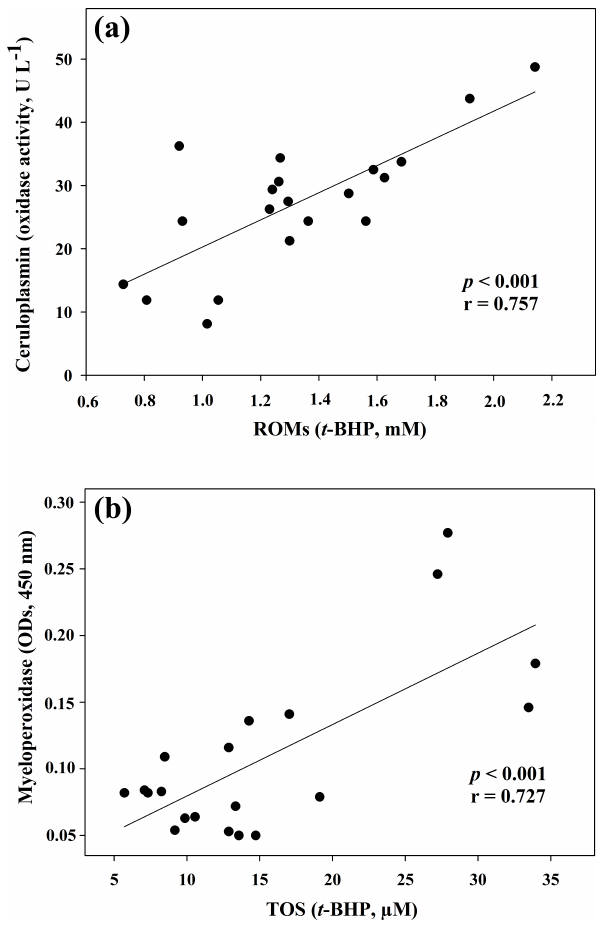
Figure 1. Regression analysis between ceruloplasmin and reactive oxygen metabolites (ROMs) (a) and between myeloperoxidase and total oxidant status (TOS) (b) in goat kid